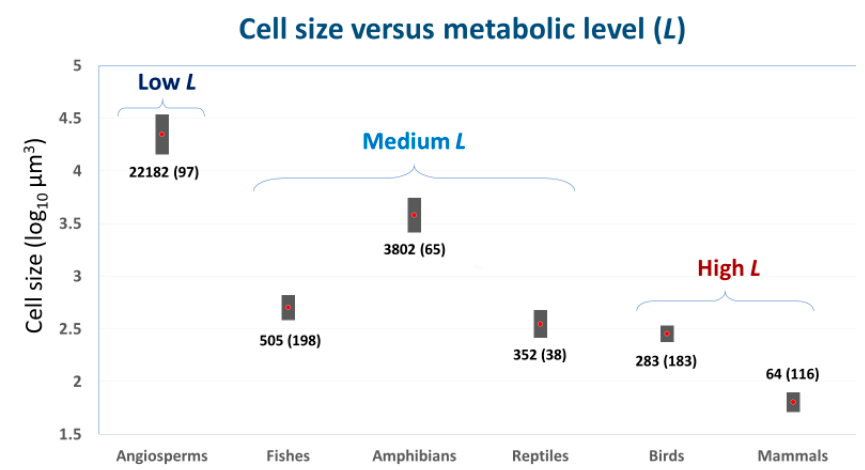
Figure 1. Means (red dots) and ranges (dark vertical bands) of cell size (log 10 µ m 2 ; data from [71]) in relation to metabolic level ( L ) of six major taxonomic groups of multicellular organisms. Mean cell sizes (number of species sampled in parentheses) are indicated (based on epidermal cells in the angiosperms, and erythrocytes in the animal taxa). Low L ≈ − 2.3; medium L ≈ − 1.5 to − 1.1; high L ≈ 0 to − 0.5 ( L = log 10 mL O 2 g − 1 h − 1 at midpoint of log 10 body-mass range; data from Figure 3 in [29]). Note the apparent negative correlation between cell size and L , as expected from cell-size surface area theory (see text). The especially small cell sizes observed for mammals may be in part due to their erythrocytes having no nuclei. Cell size also appears to be positively related to the metabolic scaling exponents ( b ) of these taxa (angiosperms: 1.06; fishes: 0.88; amphibians: 0.88; reptiles: 0.76; birds: 0.64; mammals: 0.68; data from [29,50]; see also Section 2.3.5).